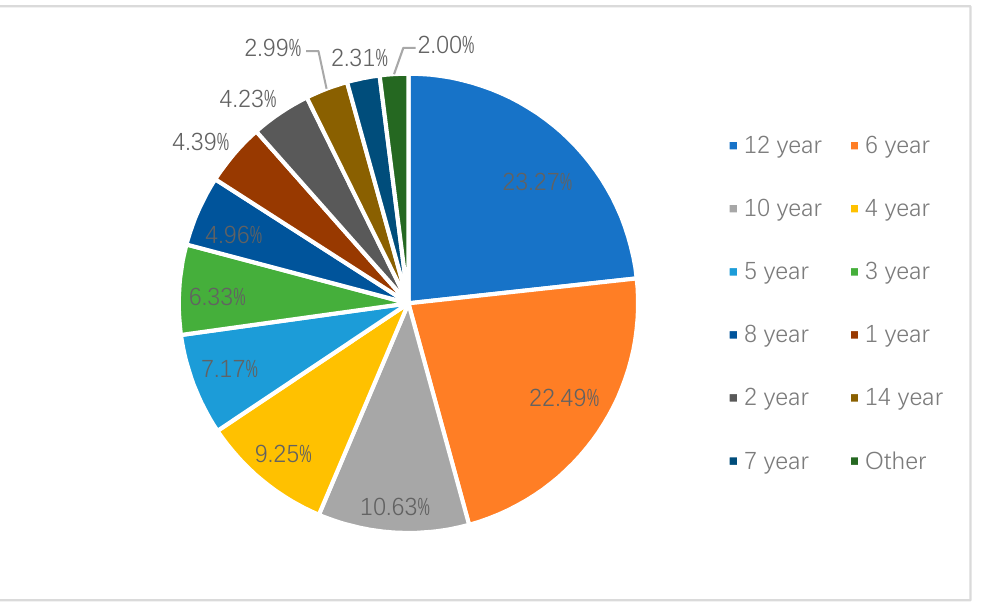
Figure 3. Recognized age criteria of national child restraint legislation by parents in Shenzhen.